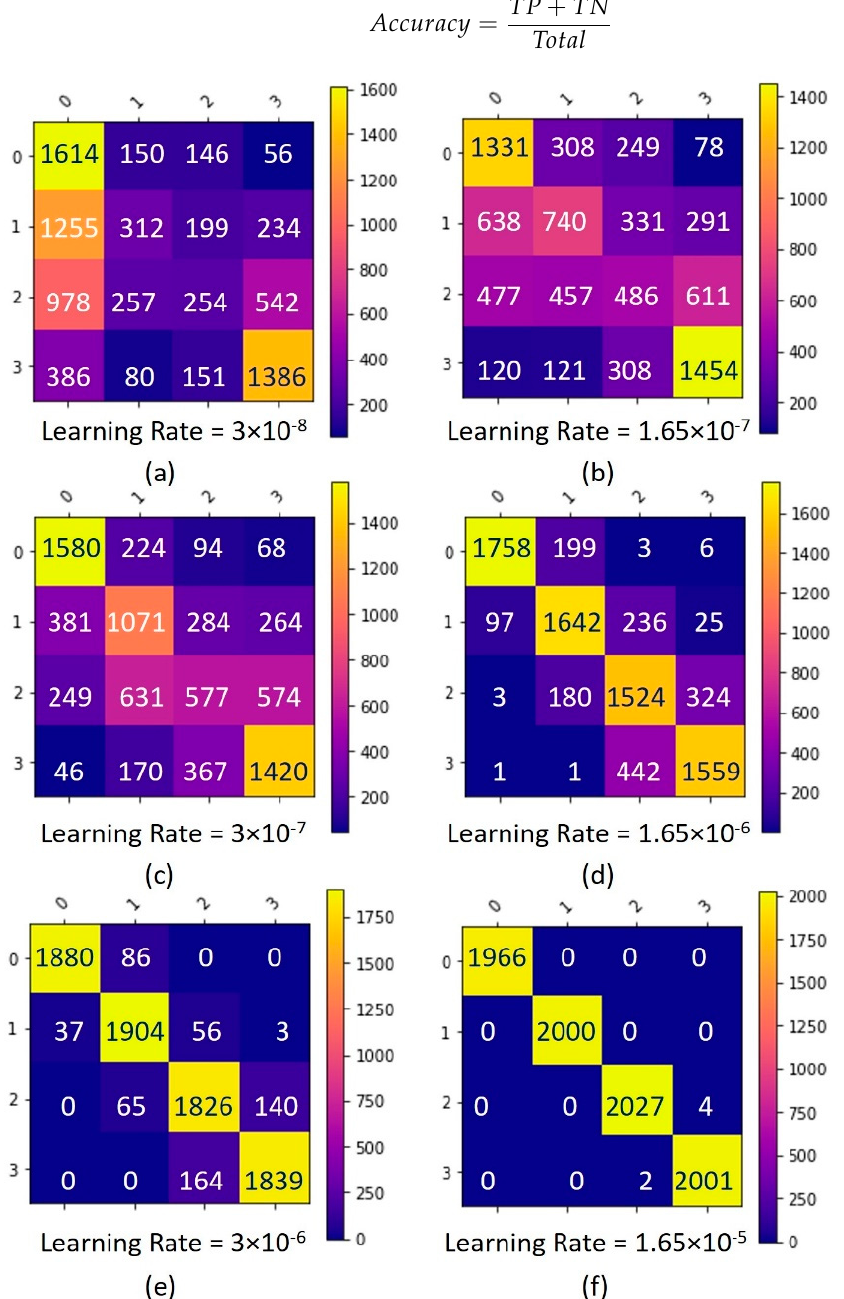
Figure 8. Confusion matrix for first search learning rate tuning.